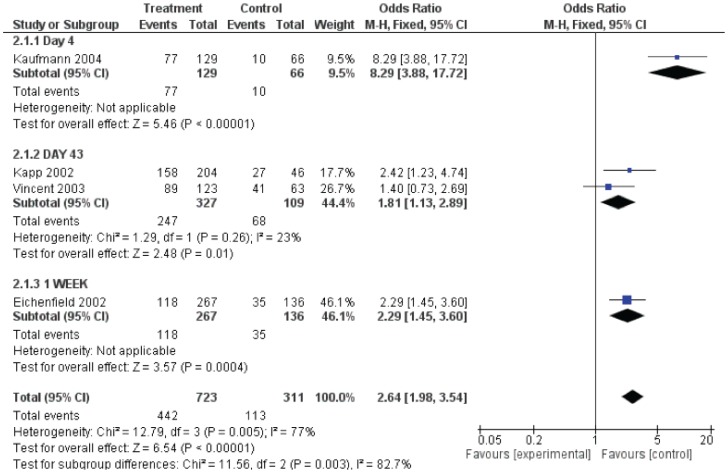
Analysis of pruritus (pimecrolimus vs vehicle).